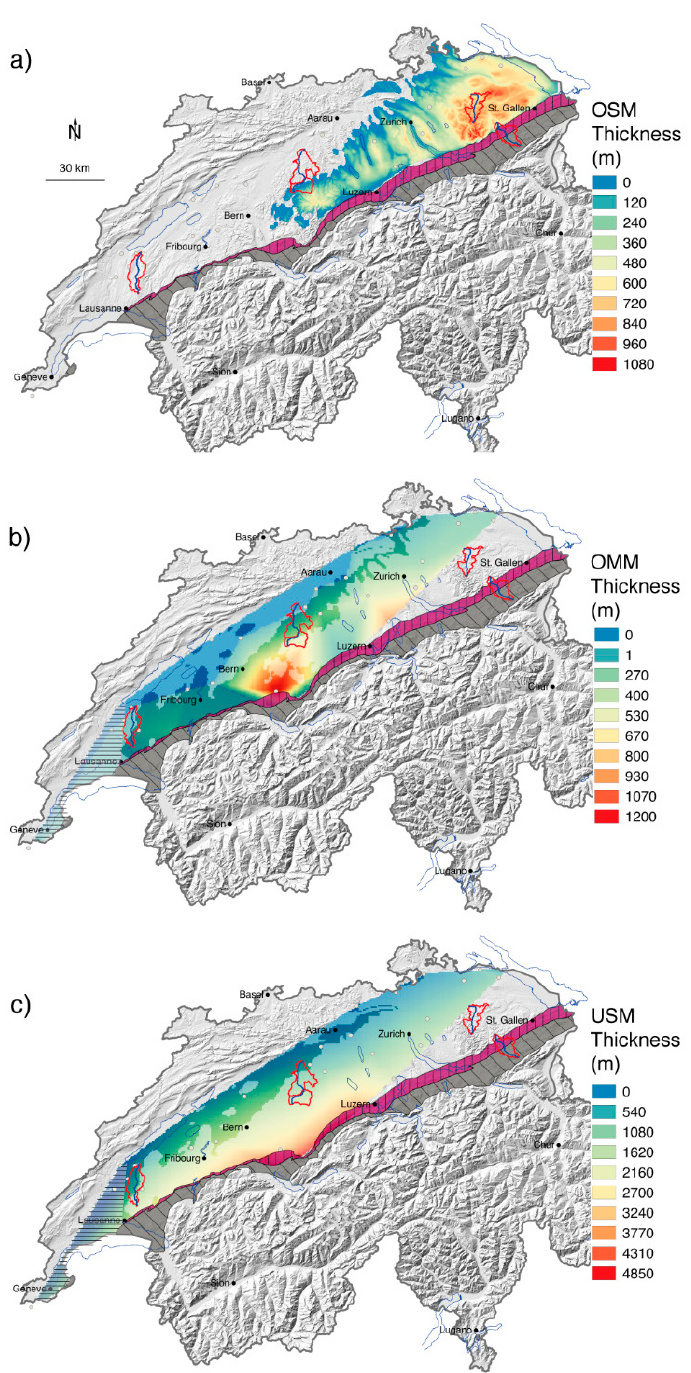
Figure 3. Thickness maps of ( a ) the upper freshwater Molasse (OSM), ( b ) the upper marine Molasse (OMM), and ( c ) the lower freshwater Molasse (USM). Maps are based on isohypses of the OSM base [37] for ( a ) and logs of 33 deep boreholes for ( b ) and ( c ) (see Section 2 for references). Strong colors indicate where the respective Molasse unit outcrops at the surface or is present below Quaternary deposits (cf. Figure 1a). The horizontally hatched area in the west delineates an area with increased uncertainty of the thickness maps due to tectonic faulting.